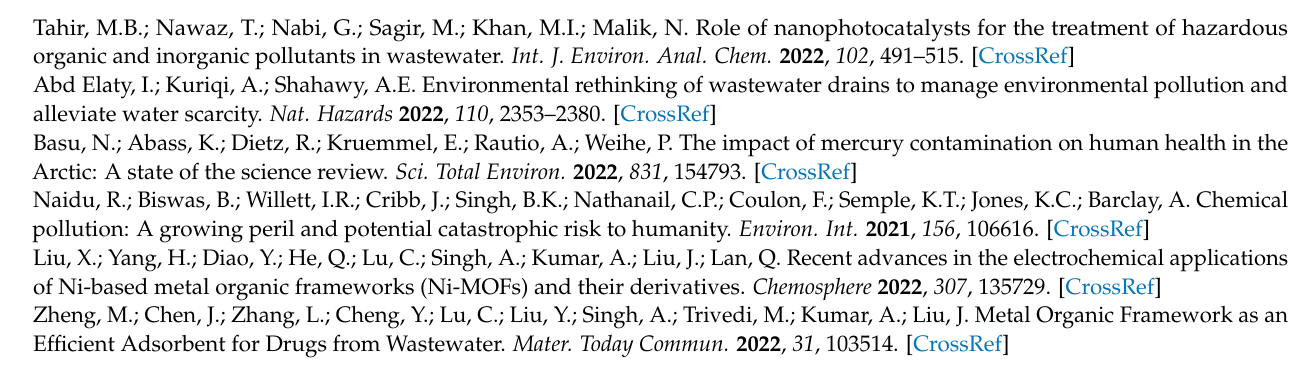
Figure S1. Influence of scan rate on the anodic peak current of the NBS in supporting electrolyte of PBS of pH 6.0; Figure S2. Calibration plot between the log peak current vs. log scan rate of NBS oxidation; Figure S3. A plot of Ip vs. v of NBS oxidation; Figure S4. A plot of Ip vs. v 1/2 of NBS oxidation; Figure S5. Bar graph of the oxidation peak current of NBS vs. various supporting electrolytes; Figure S6. Effect of accumulation potential on the peak current of 10 µ M NBS in PBS of pH 6.0 using COOH- f MWCNTs/GCE; Figure S7. A plot of Ip vs. deposition potential; Figure S8. Peak current response of 10 µ M NBS at different deposition times; Figure S9. Plot between peak current vs. deposition time of NBS oxidation; Figure S10. Kinetic study of NBS photocatalytic degradation using SWV data; Figure S11. Percentage degradation of NBS using UV-visible Spectroscopic data; Figure S12. (a) UV-Vis spectra of the photodegradation of NBS at different time intervals after recovery of photocatalyst for the first time. (b) %age degradation of NBS at different time intervals after recovery of photocatalyst for the first time; Figure S13. (a) UV-Vis spectra of the photodegradation of NBS at different time intervals after recovery of photocatalyst for the second time. (b) %age degradation of NBS at different time intervals after recovery of photocatalyst for the second